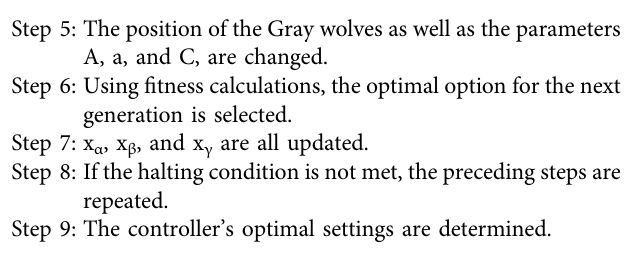
(V s ), source current (I s ), and load current (I L